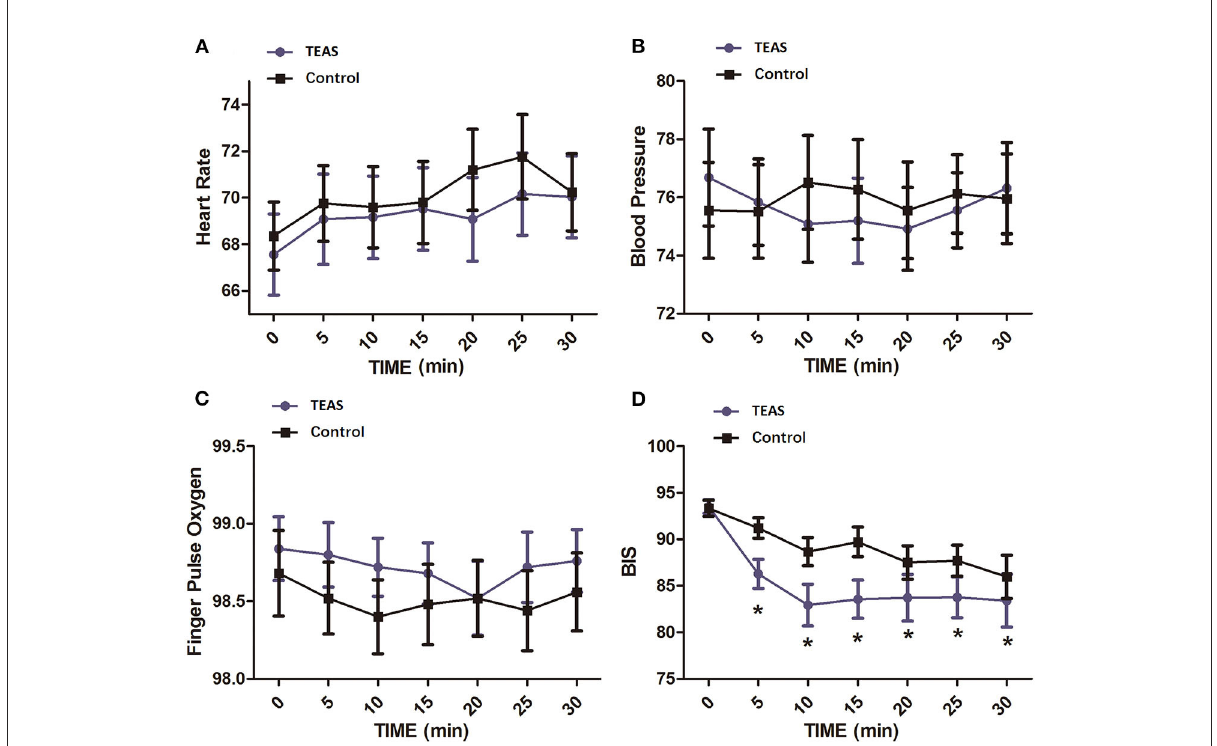
FIGURE2 Vital signs and BIS values at different time points in healthy volunteers of the TEAS group and the control group. (A) Heart rate; (B) mean blood pressure; (C) pulse oxygen saturation; (D) BIS. The mean BIS values were significantly decreased in the TEAS group at 5, 10, 15, 20, 25, and 30min after TEAS treatment compared with the control group. * P < 0.05. TEAS, transcutaneous electrical acupoint stimulation; BIS, bispectral index.